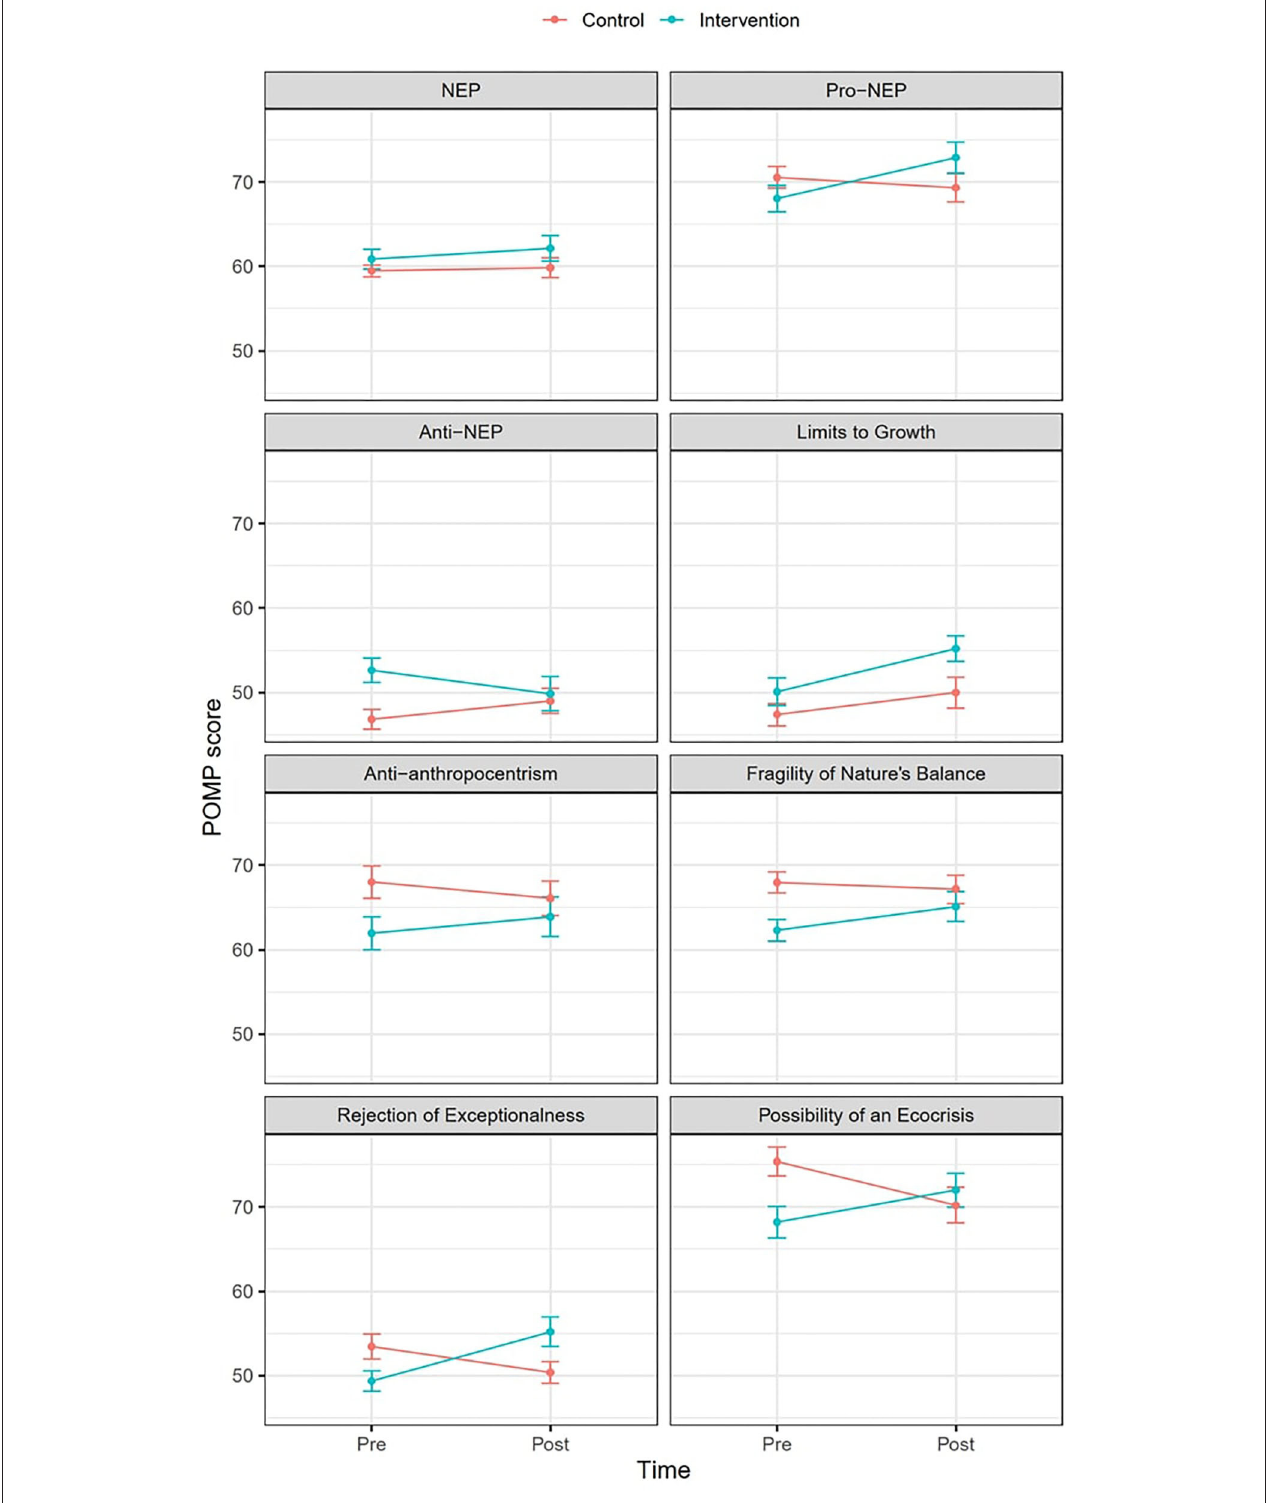
FIGURE 2 | Means (with standard error) for intervention and control groups before (pre) and after (post) the educational program.